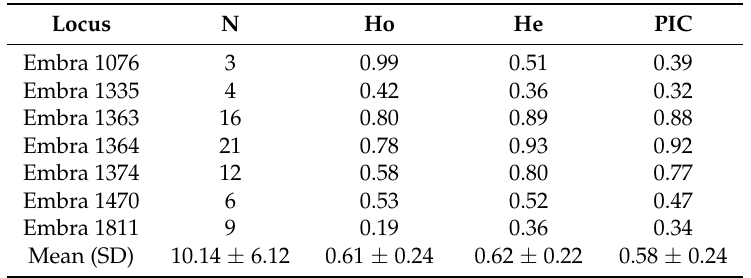
Table 1. Microsatellite genetic variation in Campomanesia adamantium ( n = 207). Locus